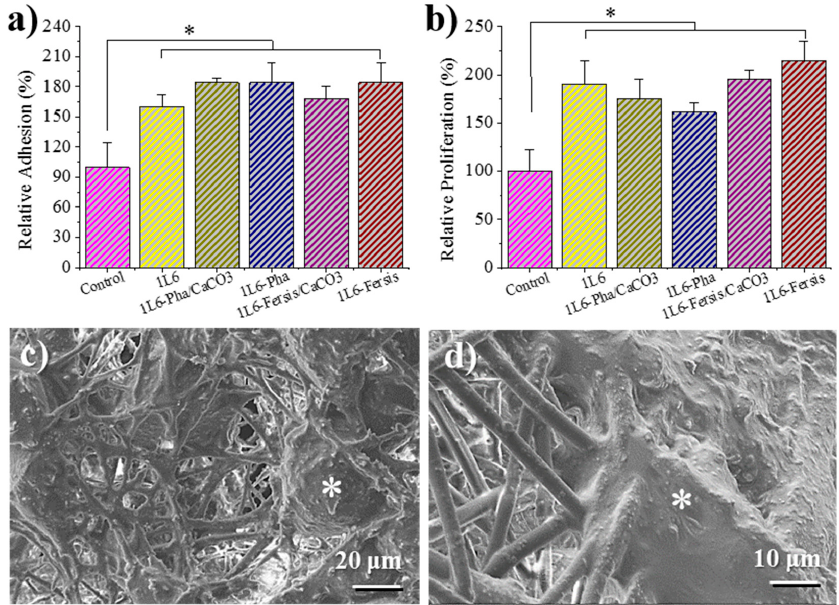
Figura 12. Biocompatibility of 1L6 matrices loaded with lyophilized Phagestaph ( a , c ) and Fersis ( b , d ) preparations by means of cell adhesion ( a ) and proliferation ( b ) assays using epithelial Vero cells. The bars are mean ± SD ( n = 4). * p < 0.05, scaffold vs. control, ANOVA followed by Tukey test.